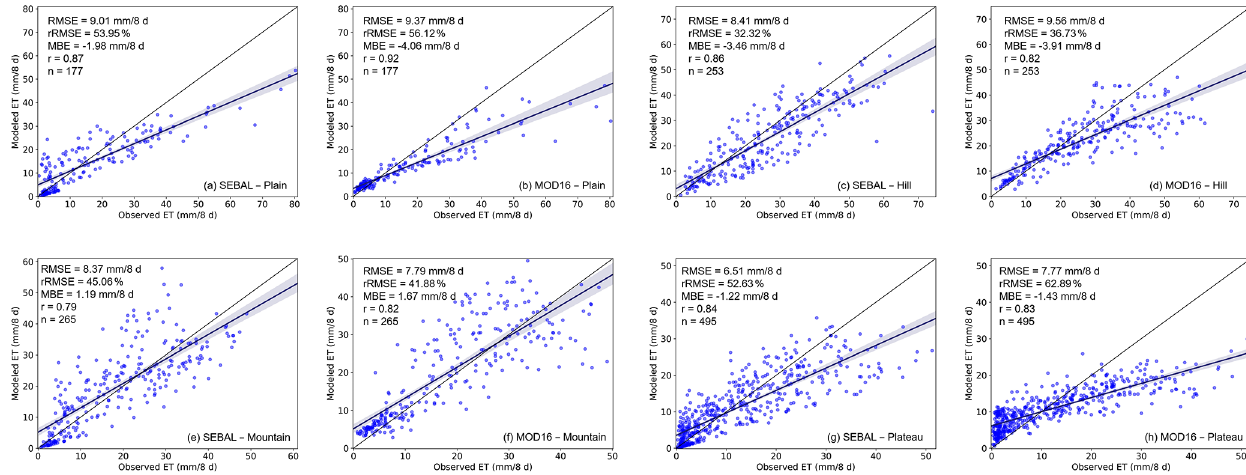
Figure 7. Validation over different terrain: (a) SEBAL ET in plain area; (b) MOD16 ET in plain area; (c) SEBAL ET in hill area; (d) MOD16 ET in hill area; (e) SEBAL ET in mountain area; (f) MOD16 ET in mountain area; (g) SEBAL ET in plateau area; (h) MOD16 ET in plateau area.